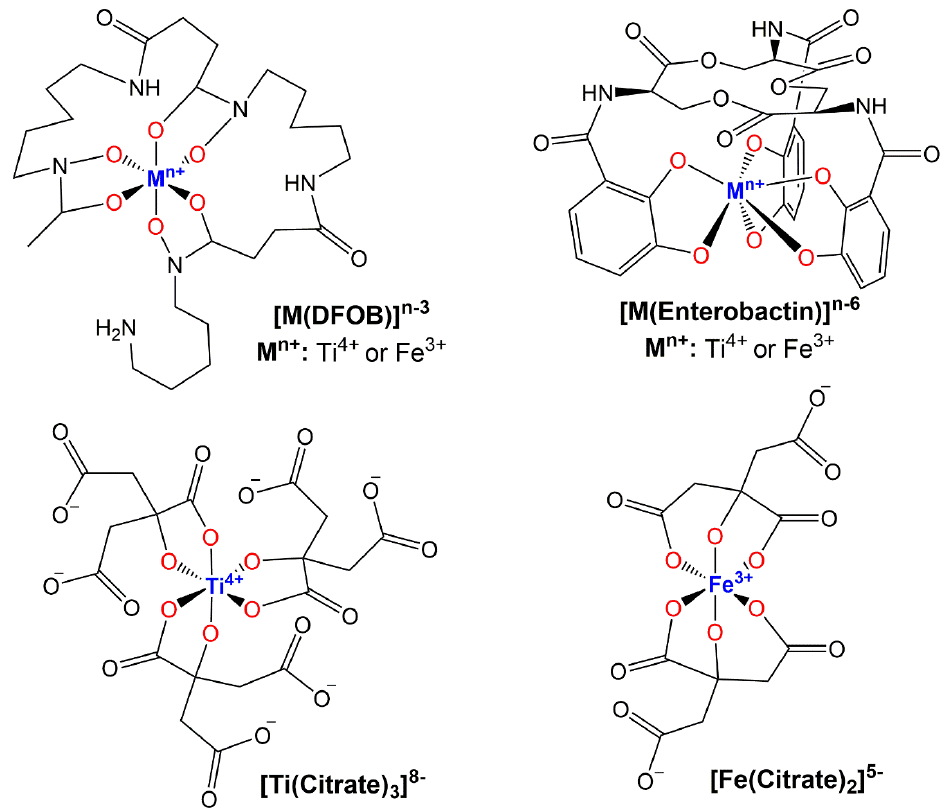
Figure 3. Coordination similarities of siderophore binding of Ti(IV) and Fe(III) at pH 7.4. The hexadentate siderophores, Desferrioxamine B (DFOB) and Enterobactin, form 1:1 metal:ligand complexes. Citrate coordinates Ti(IV) and Fe(III) in slightly different ways. Citrate serves as a tridentate ligand when coordinated to Fe(III) and as a bidentate ligand when coordinated to Ti(IV).